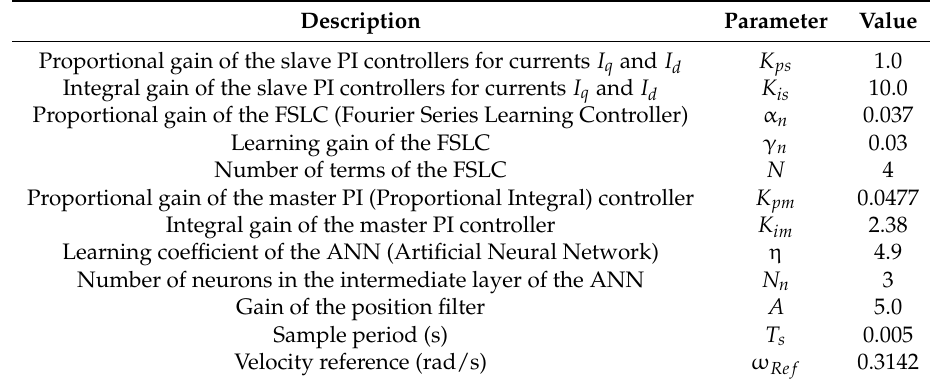
Table 1. Gains and parameters of the control